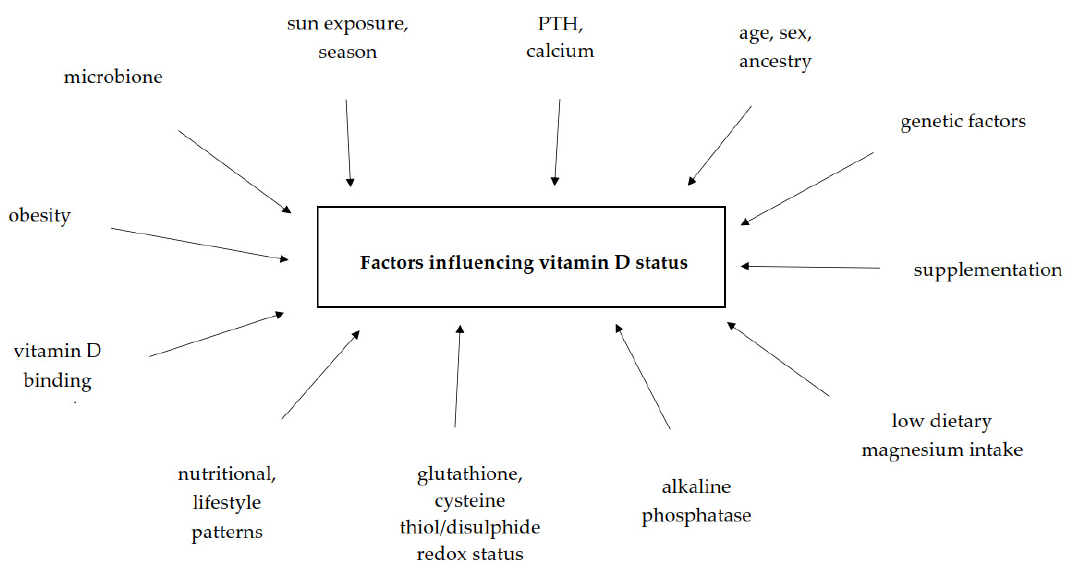
Figure 2. Determinants of vitamin D status in the human body.